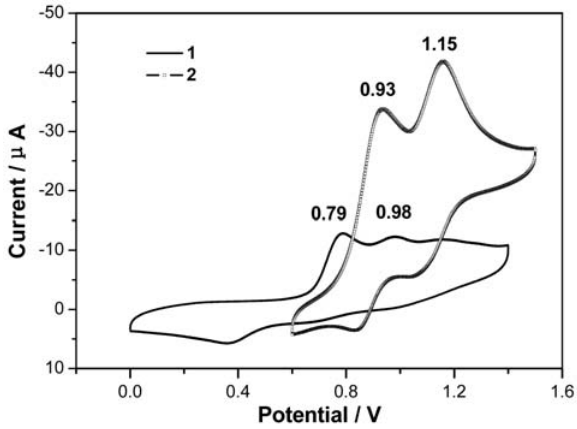
Fig. 3. Cyclic voltammogram of 1 – 2 measured in CH (1:1) solution containing n -Bu 100 mV/s.